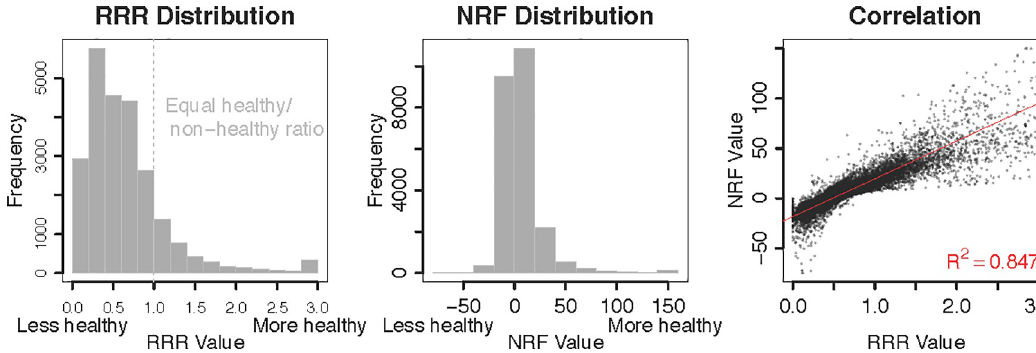
Fig 1. Distribution of RRR and NRF values and correlation between these indices. For visibility, RRR values are trimmed at 3 and NRF values are trimmed at -75 and 150. The red line indicates the least squares fit between RRR and NRF values (trimmed).